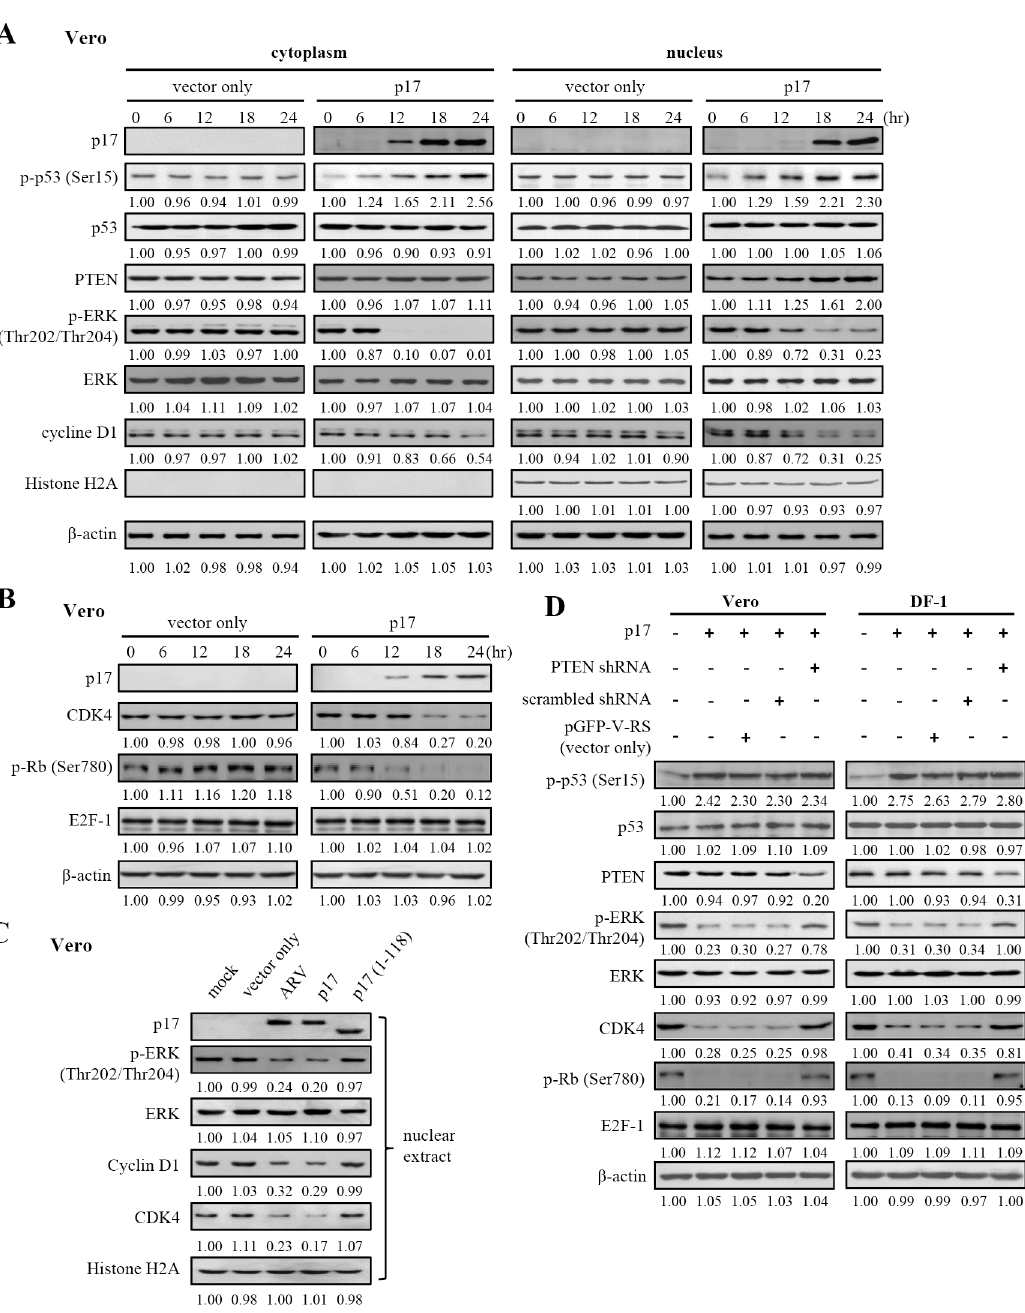
Fig 8. p17 negatively regulates ERK and cyclin D1 and positively regulates Rb through Tpr/p53/PTEN and Tpr/p53/p21 pathways. (A-B)Vero cells were transfected with pcDNA3.1-p17 or pcDNA3.1 (vector only) for 24 hours. The results of Western blot analysis of cellular fractions from the cytoplasm and nucleus (A) or whole cell lysates (B) at the indicated time points are shown. Phosphorylation and protein levels were determined by immunoblotting with the indicated antibodies. (C) To study whether the p17 mutant (1 – 118) which does not possess a NLS can affect the levels of p-ERK, cyclin D1, and CDK4 in the nucleus, vero cells were transfected with the negative control p17 mutant (1 – 118) for 24 hours. (D) To confirm whether PTEN is the upstream signaling that regulates the above molecules, shRNA-mediated blockade of PTEN was performed. Vero and DF-1 cells were co-transfected with pcDNA3.1-p17 and PTEN shRNAs for 24 hours followed by Western blot analysis with indicated antibodies. In the negative controls, cells were also co-transfected with p17 and respective negative controls (pGFP-V-RS and Scramble shRNA plasmids) for 24 hours. Phosphorylation and protein levels were determined by immunoblotting with the indicated antibodies. The protein levels were normalized to that for β -actin (panels A, B, C) or Histone H2A (panel A). The activation and inactivation folds indicated below each lane were normalized against those at 0 h or in mock control. The levels of indicated proteins at 0 h or in mock control (cell only) were considered 1-fold. The representative data are from three independent